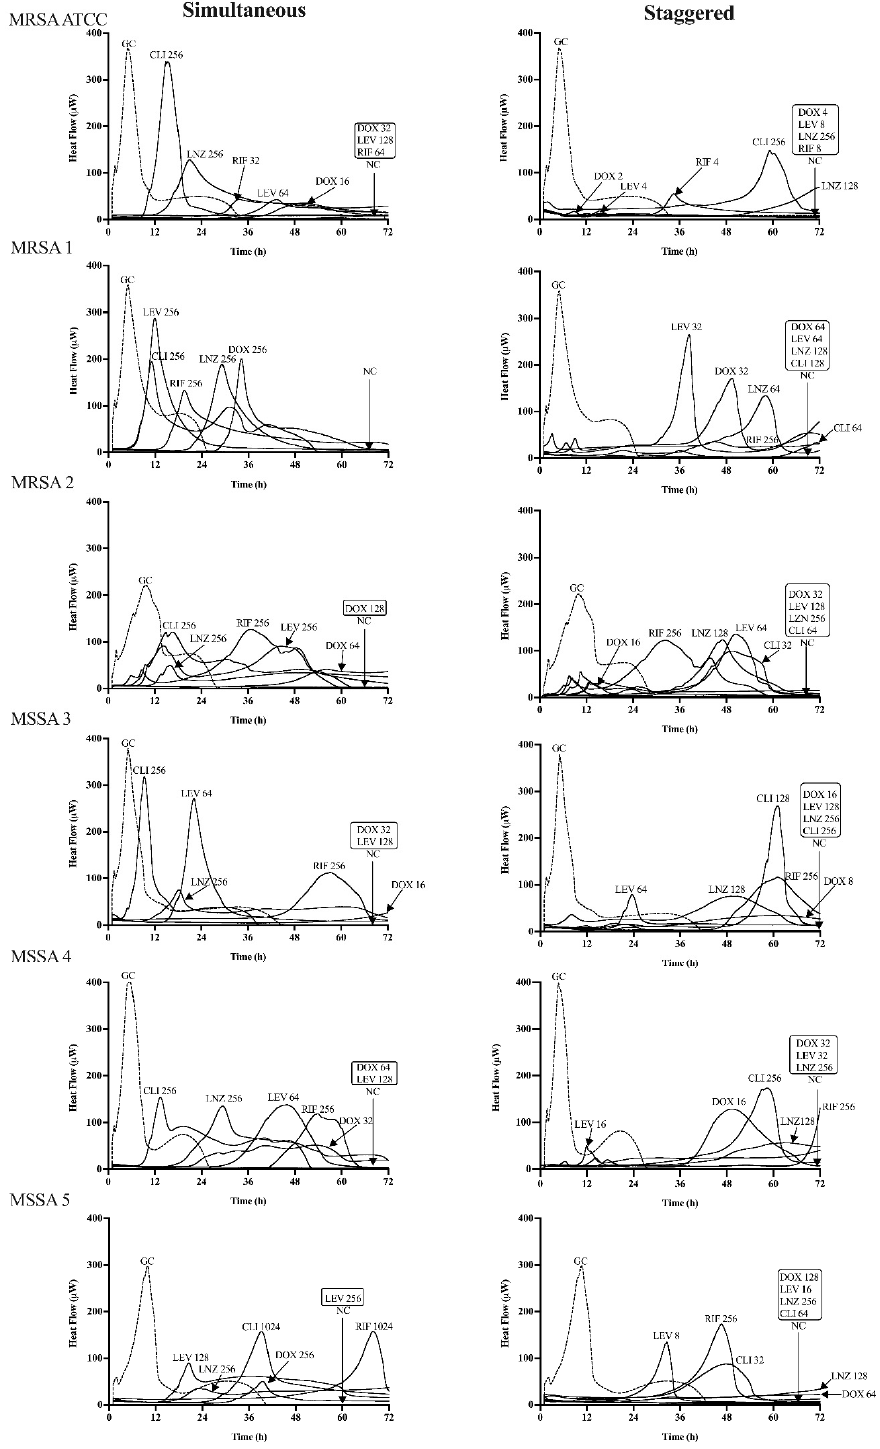
Figure3. MicrocalorimetryanalysisofthereferencestrainMRSAATCC43300andfiverifampin-resistant S. aureus strains treated with phage and sub-inhibitory concentrations of antibiotic in a simultaneous (left column) or staggered (right column) manner. Each curve shows the heat produced by viable bacteria presented in the biofilm after 24 h of phage–antibiotic treatment. Numbers represent concentrations of antibiotic (in µ g / mL) of doxycycline (DOX), levofloxacin (LEV), linezolid (LNZ), clindamycin (CLI), and rifampin (RIF). Circled values represent the MBIC, defined as the lowest antimicrobial concentration leading to the biofilm metabolism inhibition in the absence of antimicrobials for 72 h. GC, growth control; NC, negative control. Data of a representative experiment are